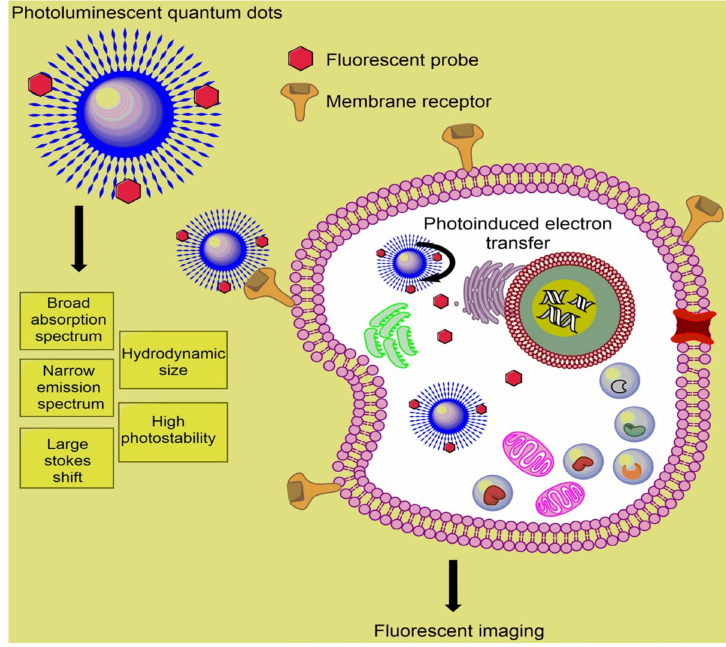
Figure 7. Interaction of quantum dots (QDs) with the membrane receptors and the mechanism of generation of florescence inside the cell for